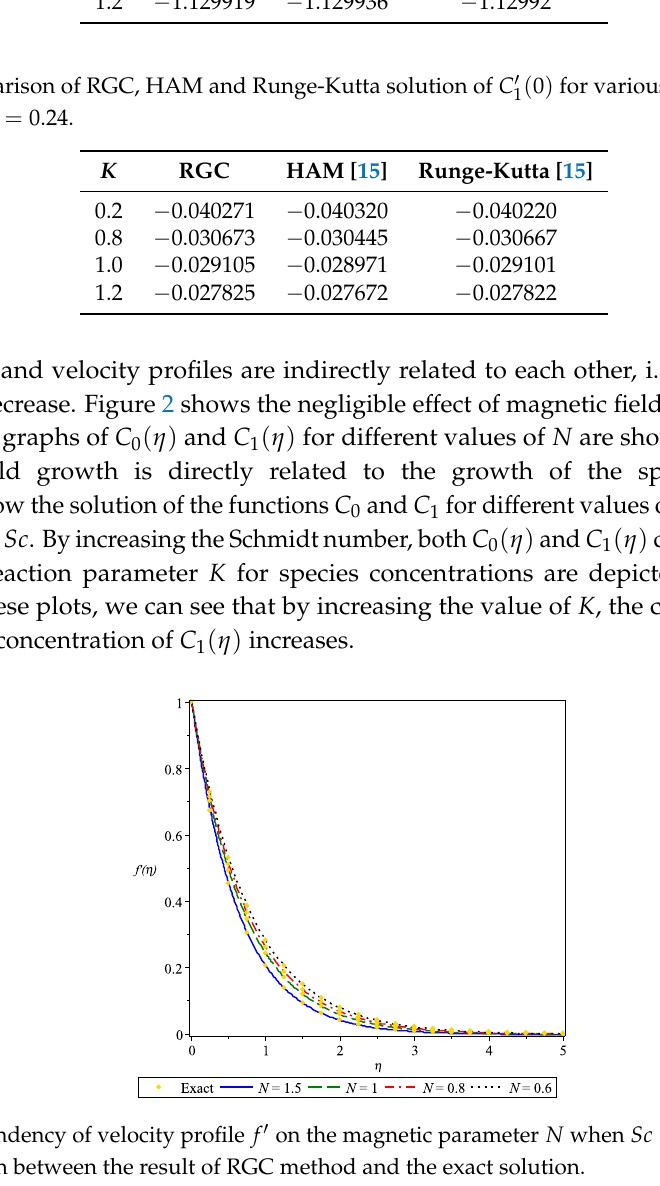
( 0 ) for various values of K while 1